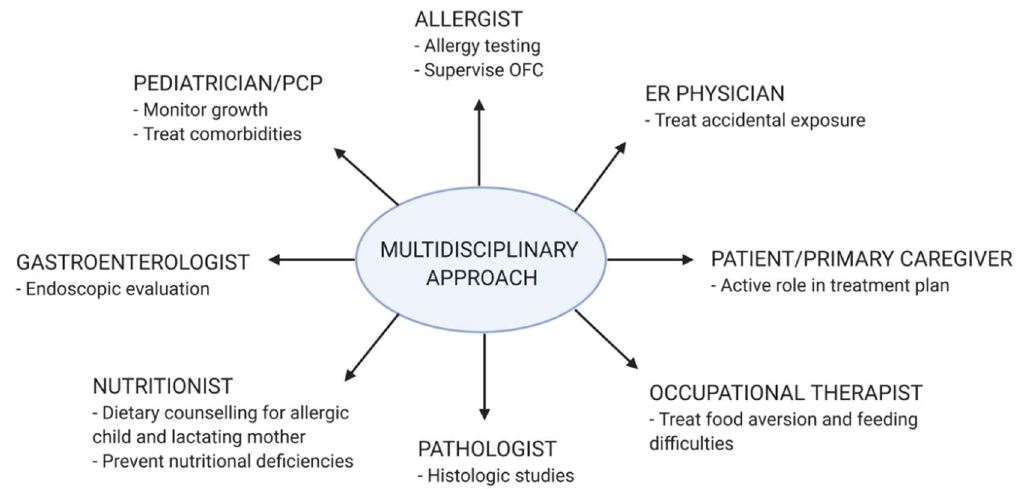
Figure 4. Multidisciplinary approach for diagnosis and management of non-IgE-mediated gastrointestinal food allergies. ER, emergency room; OFC, oral food challenge; PCP, primary care physician.